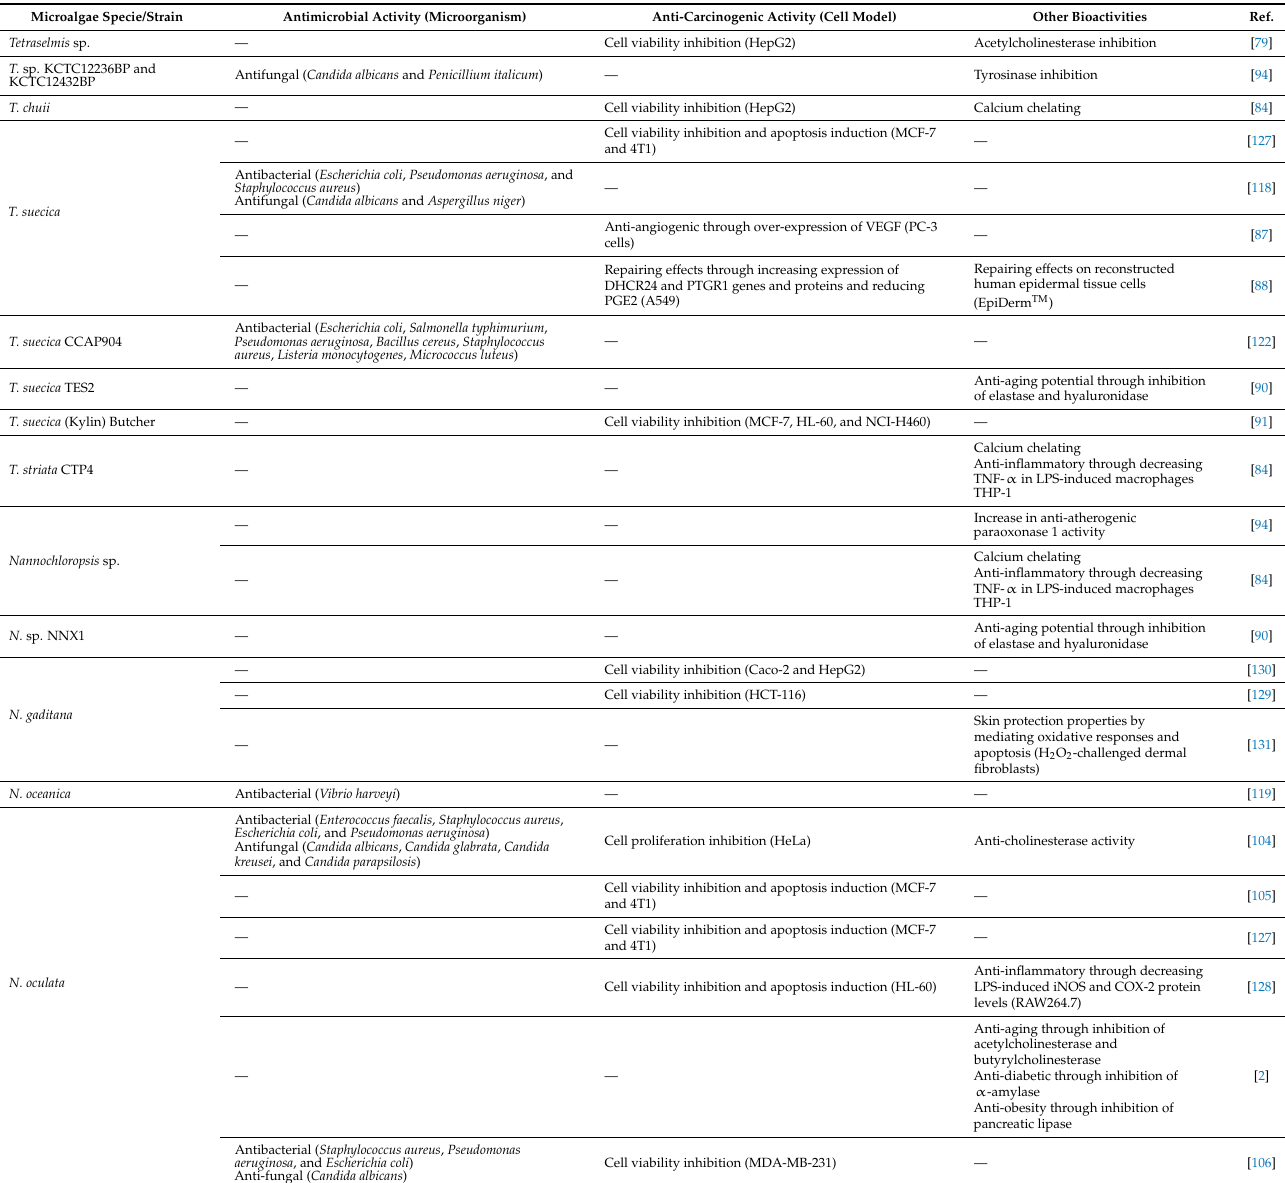
Table 8. Biological activities demonstrated for Tetraselmis and Nannochloropsis sp. microalgae extracts.